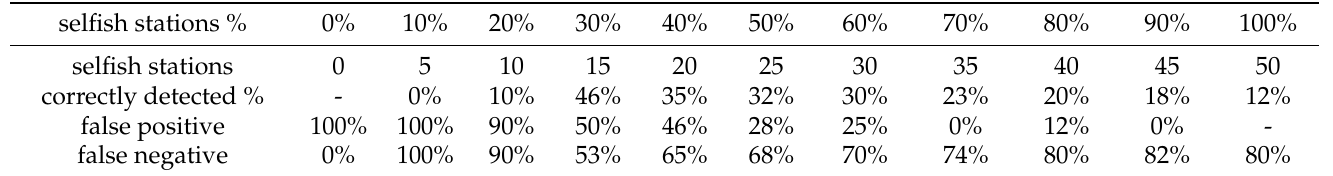
Table 5. Deviation detection mechanism for 50 stations in UDP scenario.